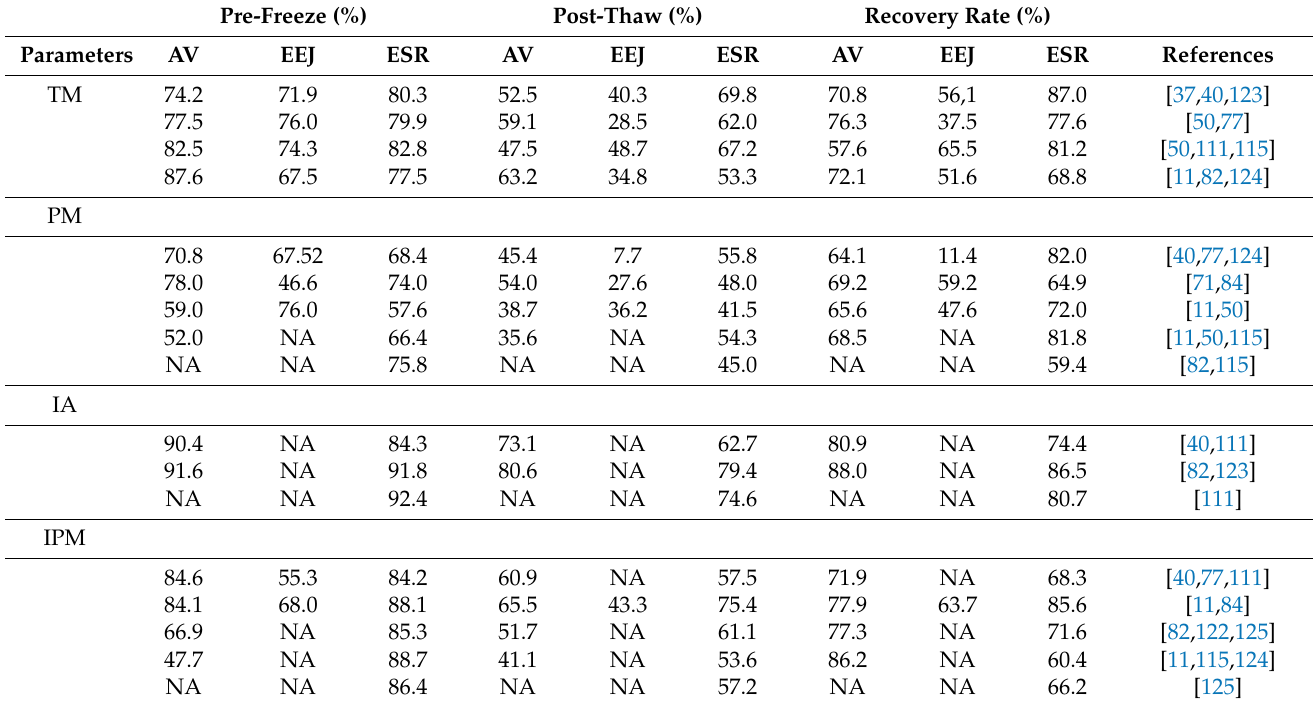
Table 3. Comparison of cryopreservation responses of artificial vagina, electroejaculation, and epididymal sperm recovered ram